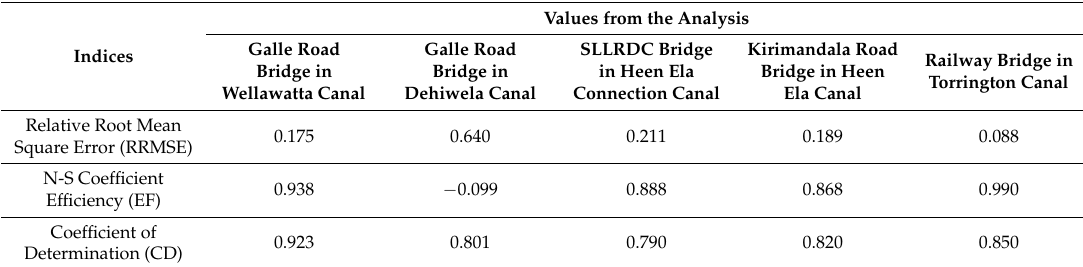
Table 2. Error estimators for the water level